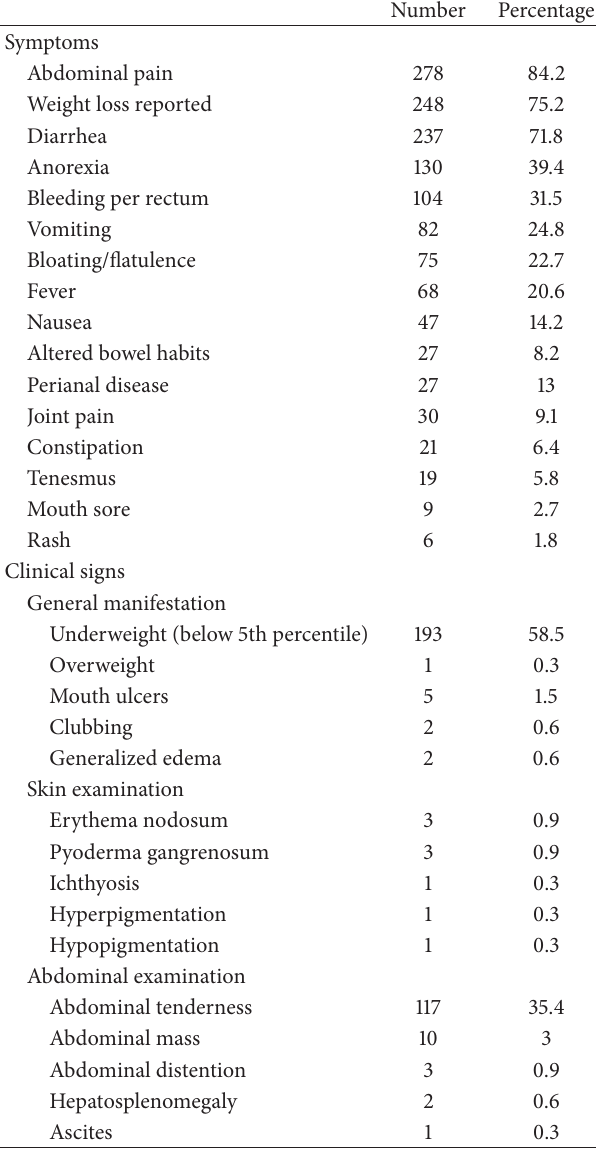
Table 1: The presenting symptoms and signs of children with Crohn’s disease ( 𝑛 = 330